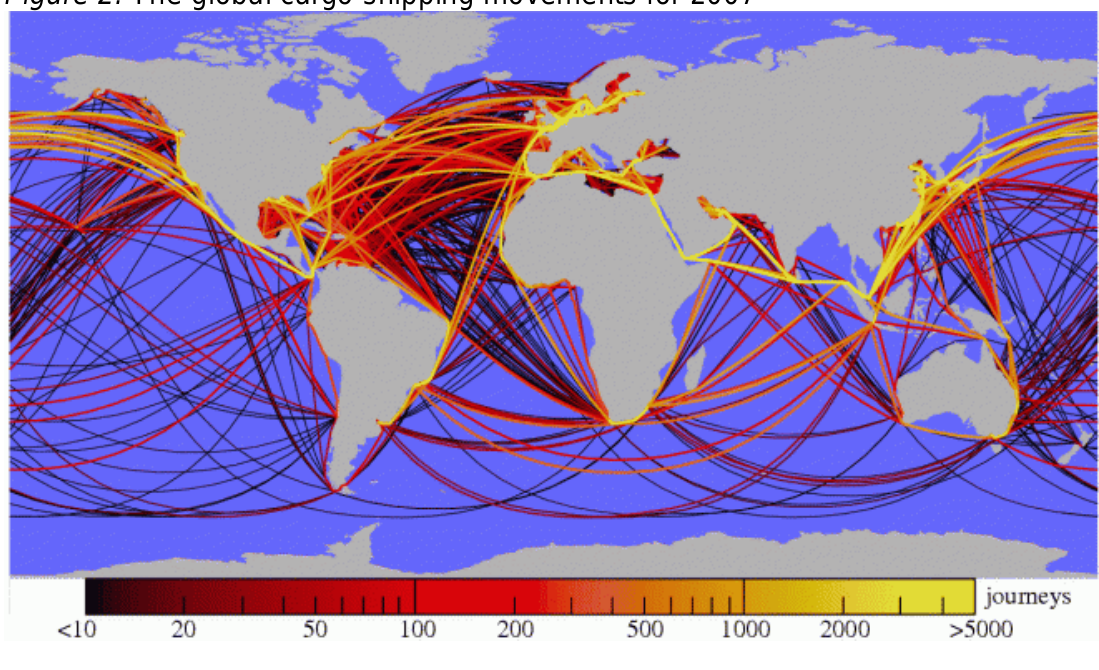
Source: Kaaluza et. al. ,